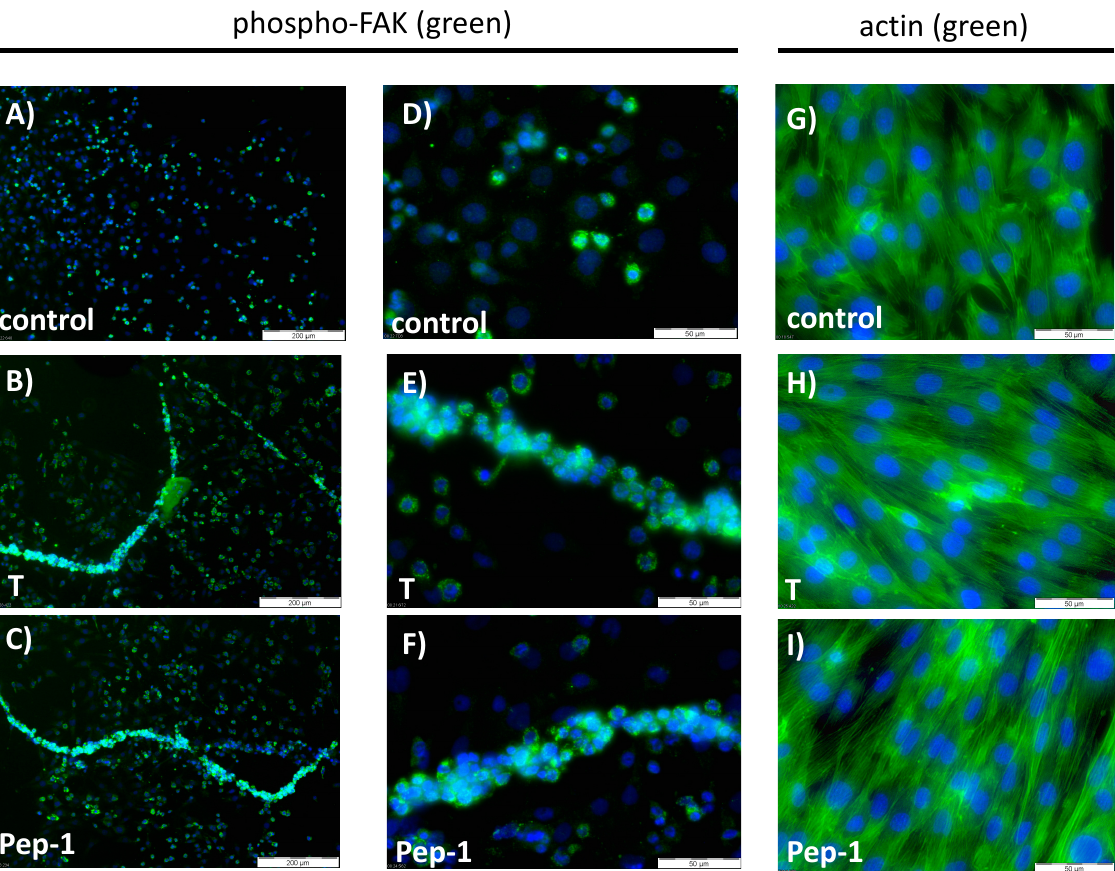
Figure 5. Demonstration of syncytial myotube formation induced by testosterone or peptides. All photomicrographs in ( A – I ) are taken after 9 h of incubation. Nuclei are stained with DAPI (blue). ( A – F ): Green fluorescence corresponds to FAK phosphorylated at Y925. ( A ) Untreated control cells. ( B ) Treatment with testosterone (T) stimulates both FAK phosphorylation and induces the formation of myotubes. ( C ) Pep-1 also stimulates FAK phosphorylation and myotube formation. ( D – F ) The higher magnification reveals single-cell structures and the focal localization of phospho-FAK. ( G – I ) Green fluorescence corresponds to actin filaments labelled with phalloidin. ( G ) Detection of phalloidin-stained actin filaments in control cells. The actin filaments are contained in each individual cell and cells are randomly oriented. ( H ) Cells treated with testosterone form parallel-oriented syncytia with actin fibers stretching over several cells. ( I ) A similar pattern as that shown in ( H ) is obtained when cells are treated with Pep-1.